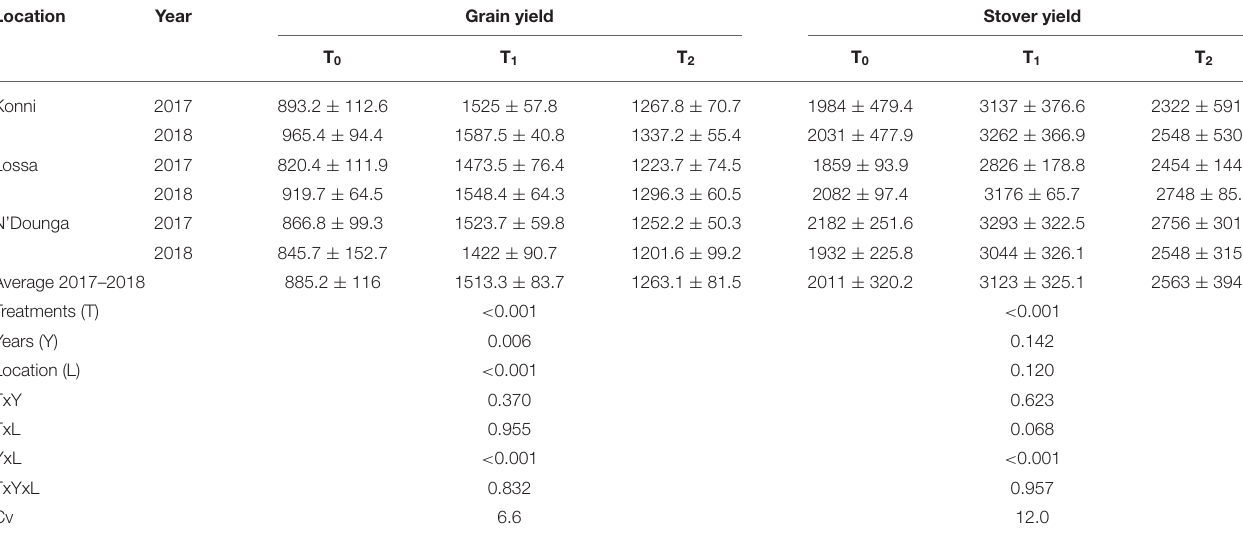
TABLE 5 | Effect of treatment on grain and stover yield (kg ha − 1 ) (standard error in parenthesis). Location